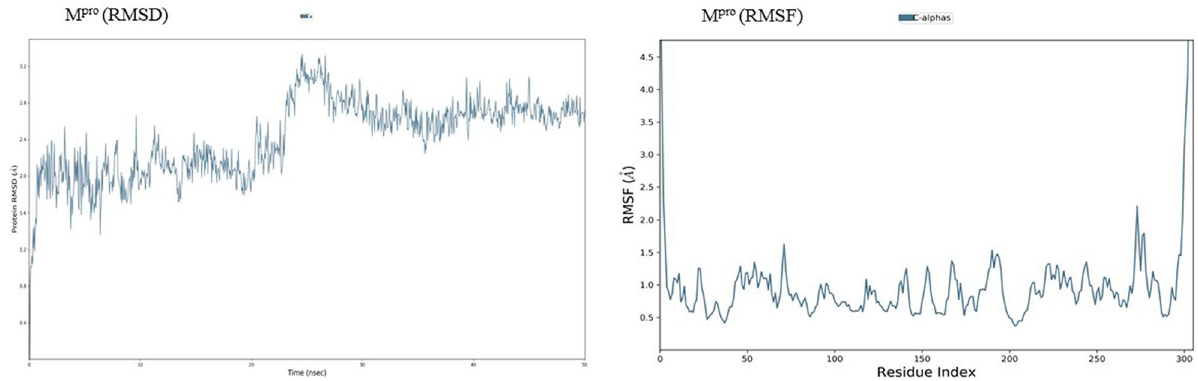
Figure 7. Root mean square deviation (RMSD) and root mean square fluctuation plots of M pro .